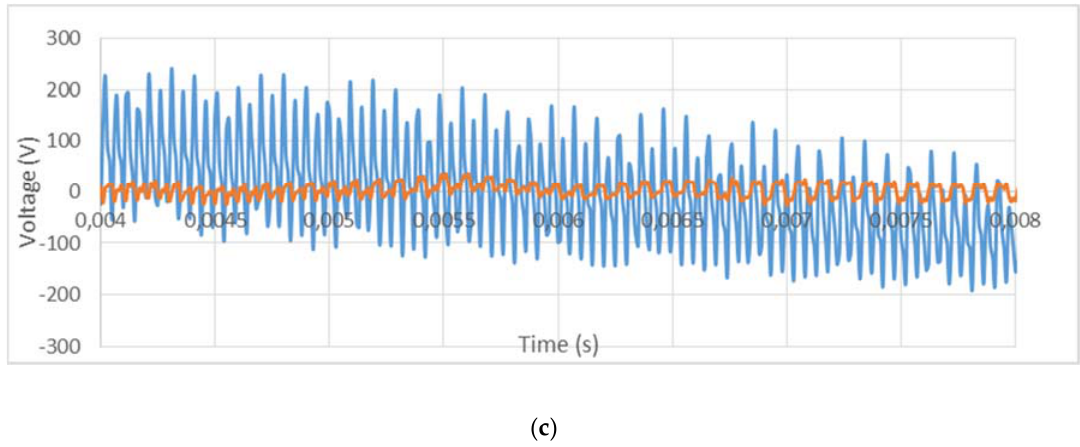
Figure 13. The enlarged waveform of the output phase voltage (blue) and CMV (orange), for the shift angle ψ = 60° ( a ); ψ = ‐ 60° ( b ) and ψ = 180° ( c ).